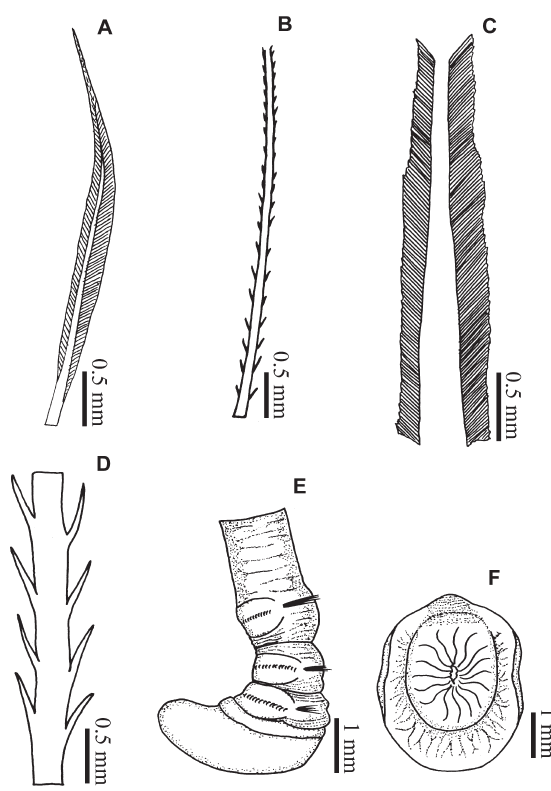
Fig . 5. – Petaloproctus vallejoi n. sp. A, bilimbate capillary chaeta from setiger 4; b, spinous capillary chaeta; C, ruffled base of the spinous capillary chaeta; D, very long, filamentous and pinnate capil- lary chaeta; E, posterior end of holotype; f, anal plate, frontal